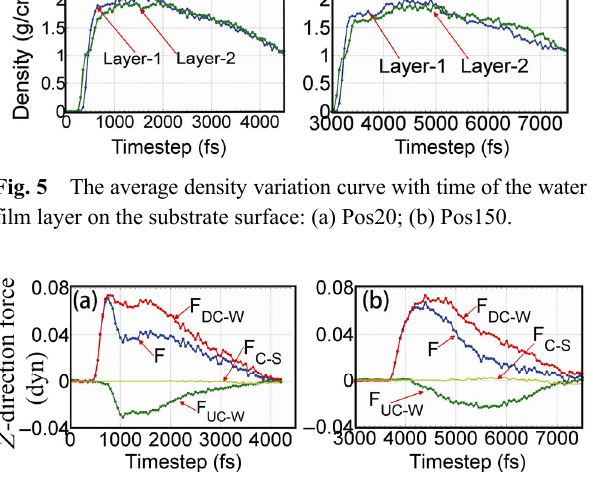
Fig. 6 Z -direction forces variation curve with time on cluster: (a) Pos20; (b) Pos150.